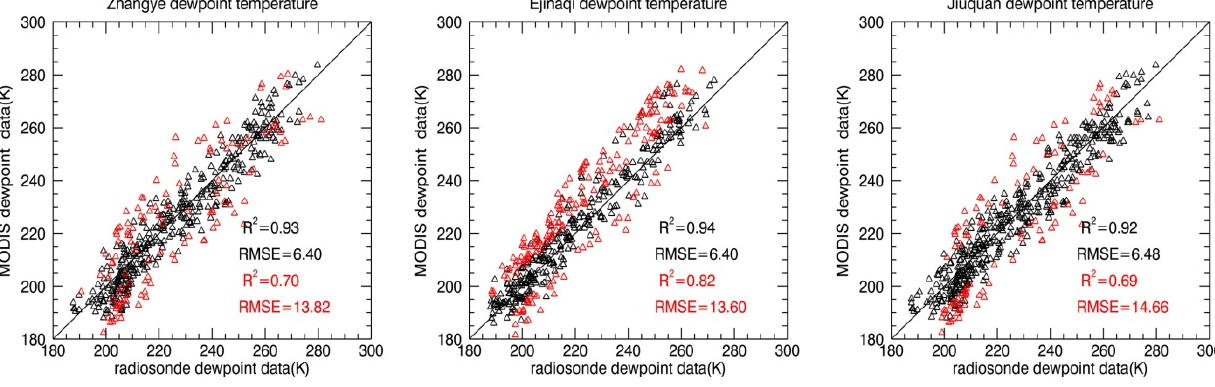
Figure 8. Validation between MODIS moisture data and radiosonde data for 2012 at Zhangye, Jiuquan and Ejinaqi stations for regular pressure